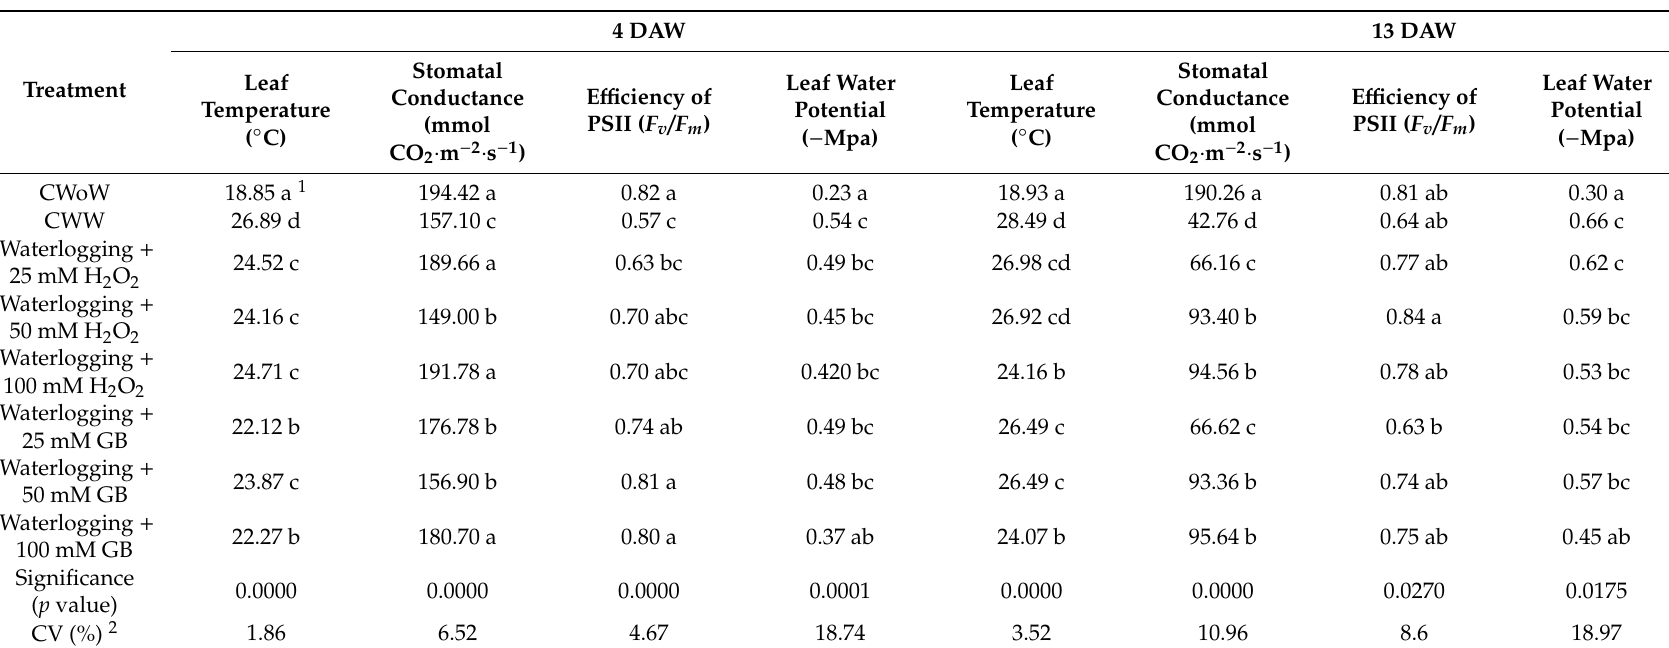
Table 2. Estimation of physiological parameters: Leaf temperature, stomatal conductance, e ffi ciency of photosystem II (PSII) ( Fv / Fm ), and leaf water potential in Cape gooseberry ( Physalis peruviana L.) plants ecotype Colombia subjected to a waterlogging period with exogenous applications of 25, 50, and 100 mM of hydrogen peroxide (H 2 O 2 ) or glycine betaine (GB), respectively. Control without waterlogging (CWoW) and control with waterlogging (CWW). Evaluated at 4 and 13 Days After Waterlogging